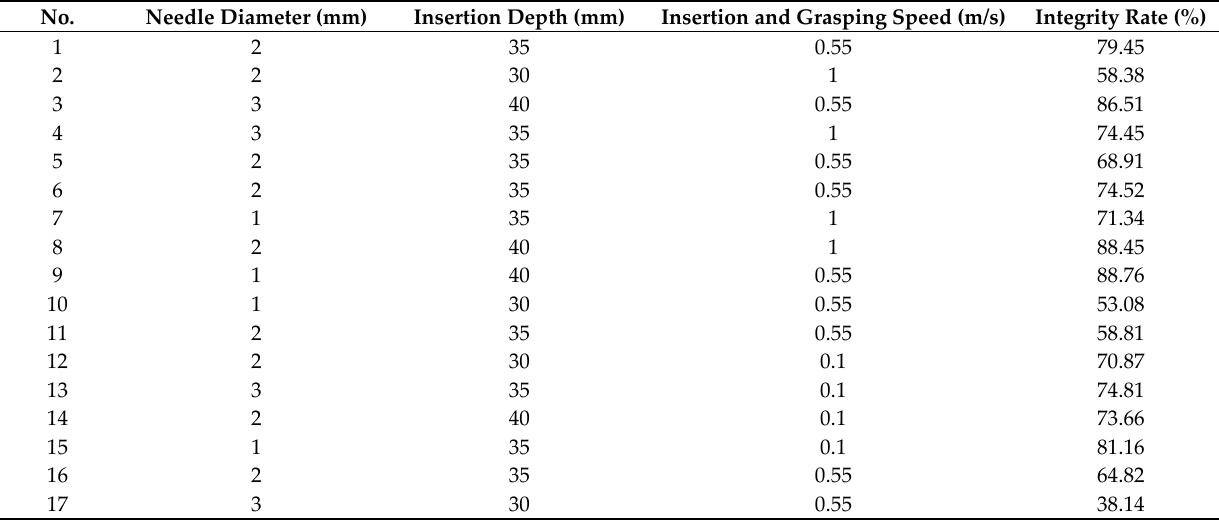
Table 3. Results of EDEM